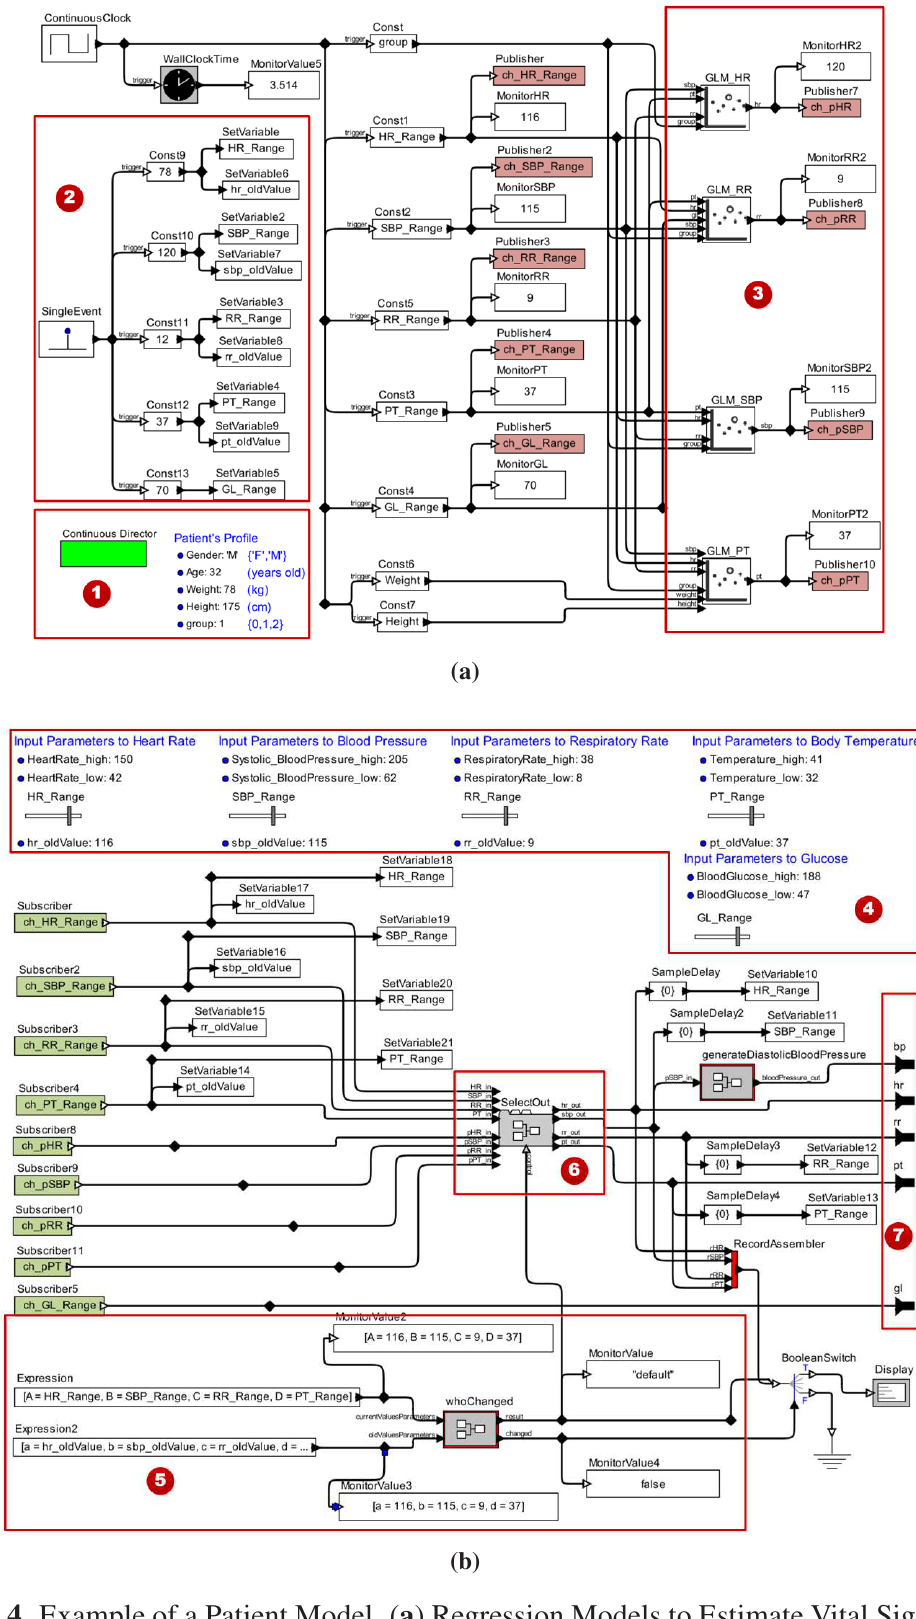
Figure 4. Example of a Patient Model. ( a ) Regression Models to Estimate Vital Signs Data; ( b ) Submodel to Provide Information to the Medical Device